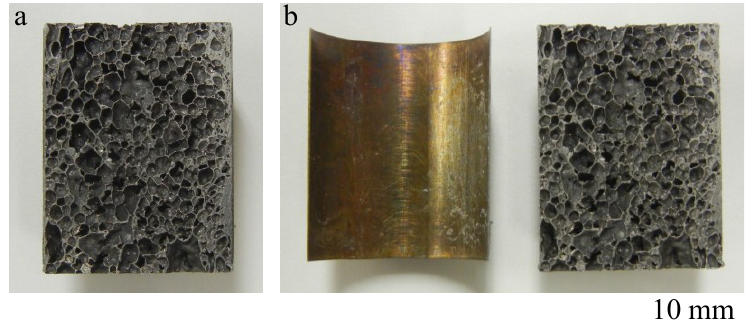
Figure 5. Fabricated Al foam-filled steel tube in which precursor was only placed in steel tube for foaming, i.e. , precursor was not bonded to steel tube by friction